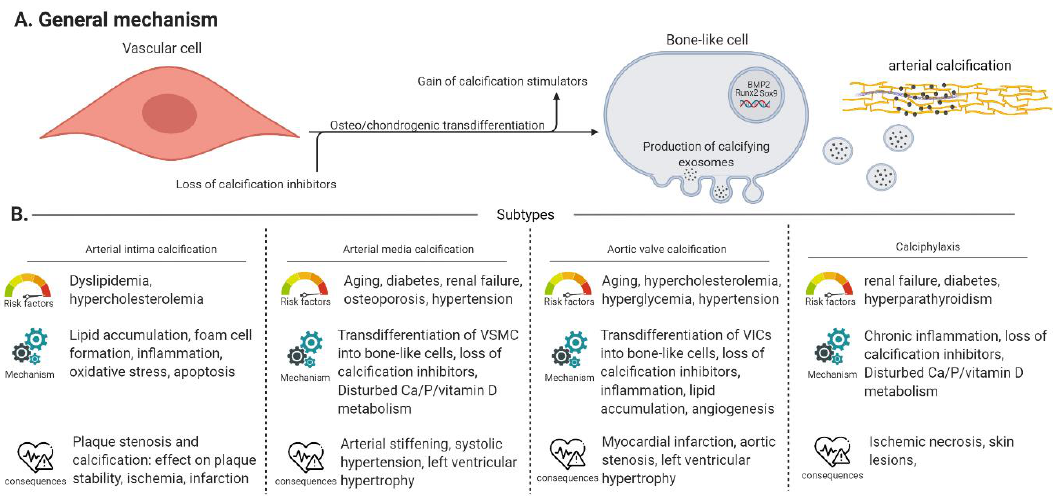
and clinical consequences of arterial intima/media calcification, aortic valve calcification and calciphylaxis. VSMC: vascular smooth muscle cell, VIC: valve interstitial cell, Vascular cell: covers VSMCs, VICs and endothelial cells.